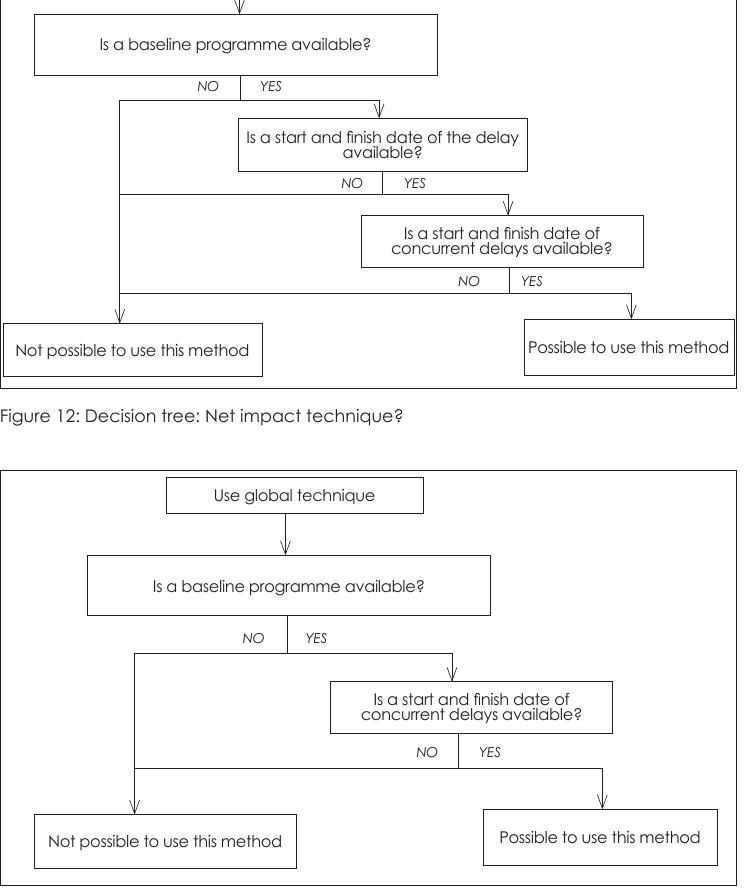
Figure 13: Decision tree: Use Global impact